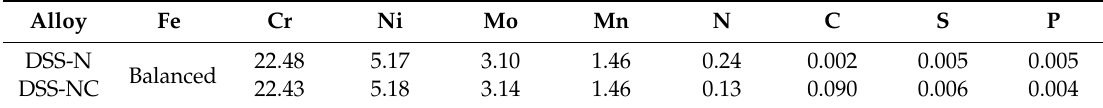
Table 1. Chemical compositions (in wt%) of the investigated